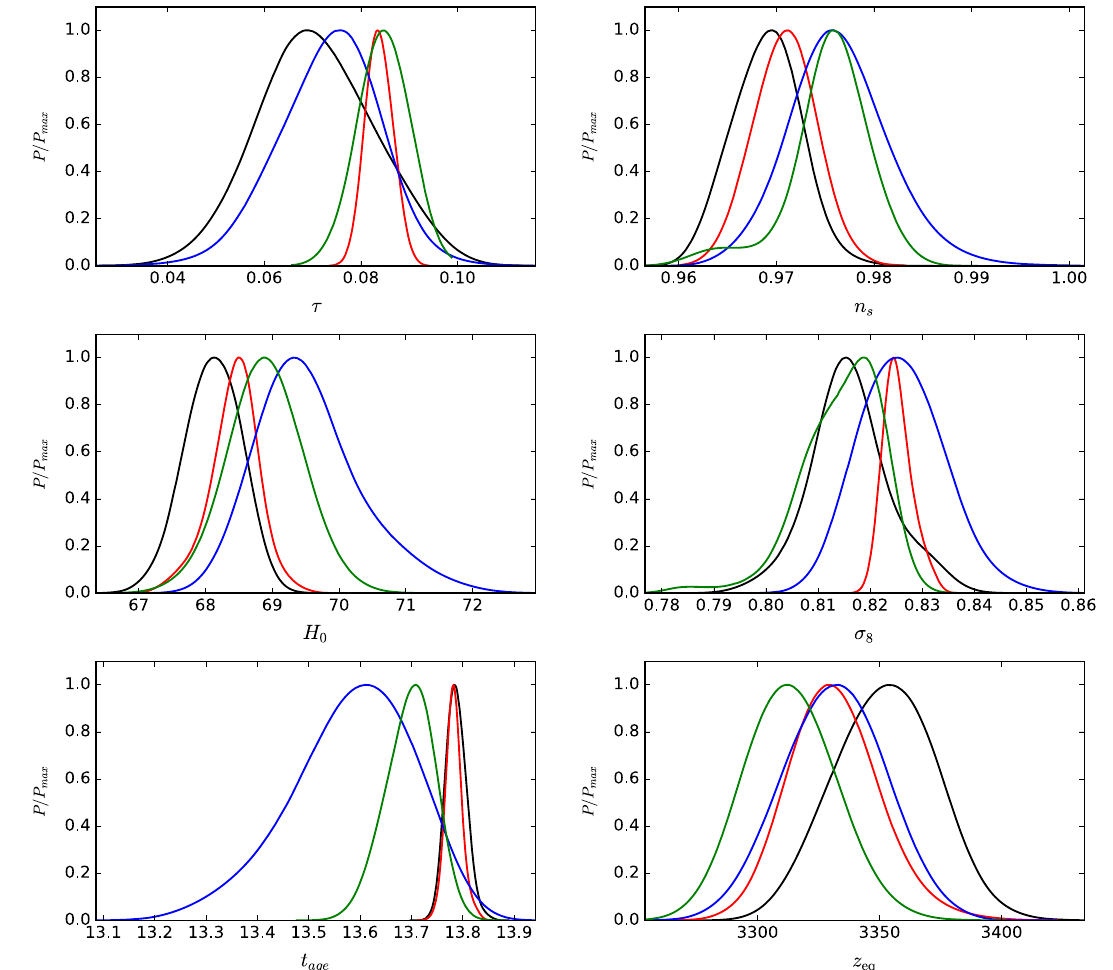
Fig. 7 The 1-dimensional posterior distributions of τ , n s , H 0 , σ 8 , t age and z eq in the (cid:5) CDM (black), F (cid:5) (red), Fs (blue) and Fms (green) models by using the data combination CBSLCH, respectively